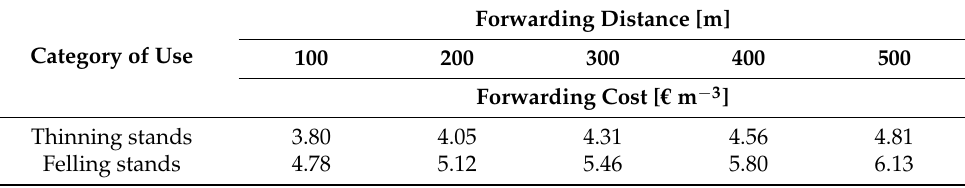
Table 6. Direct costs [ € ] of forwarding of 1 m 3 of short wood in the distance of 100–500 m.